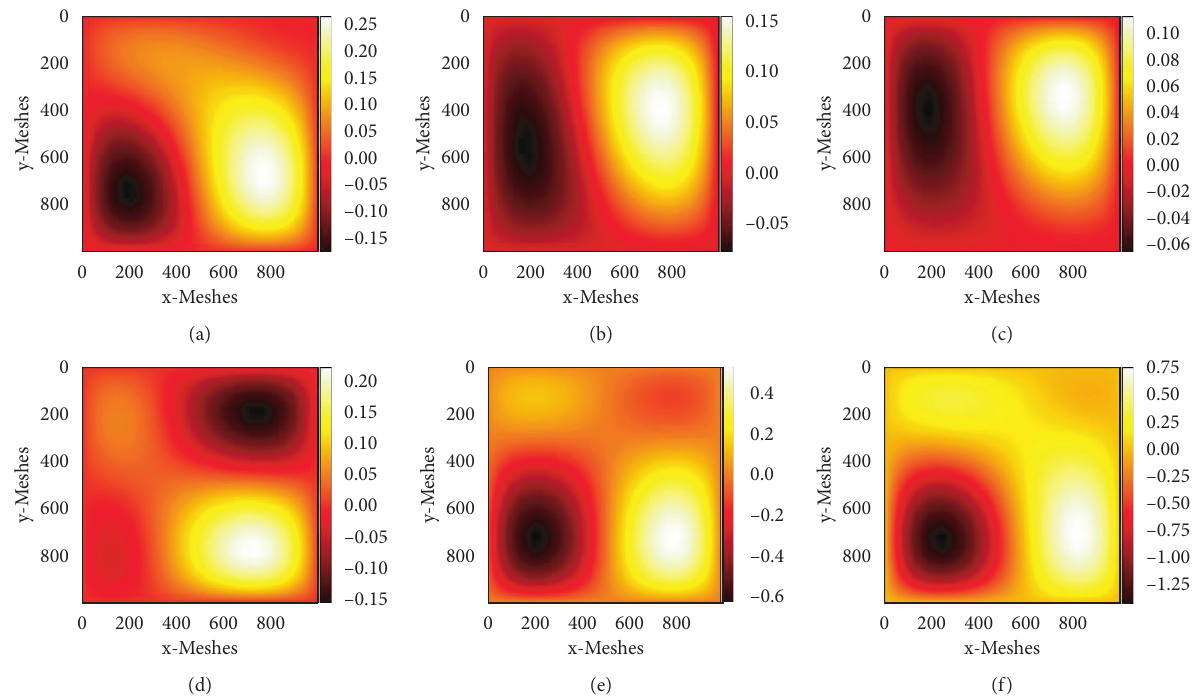
Figure 2: . Plots for Density of particles at N � 50 ,M t � 3.66, α � 0.2. (e) t � 3.66, α � 0.6. (f) t � 3.66, α �